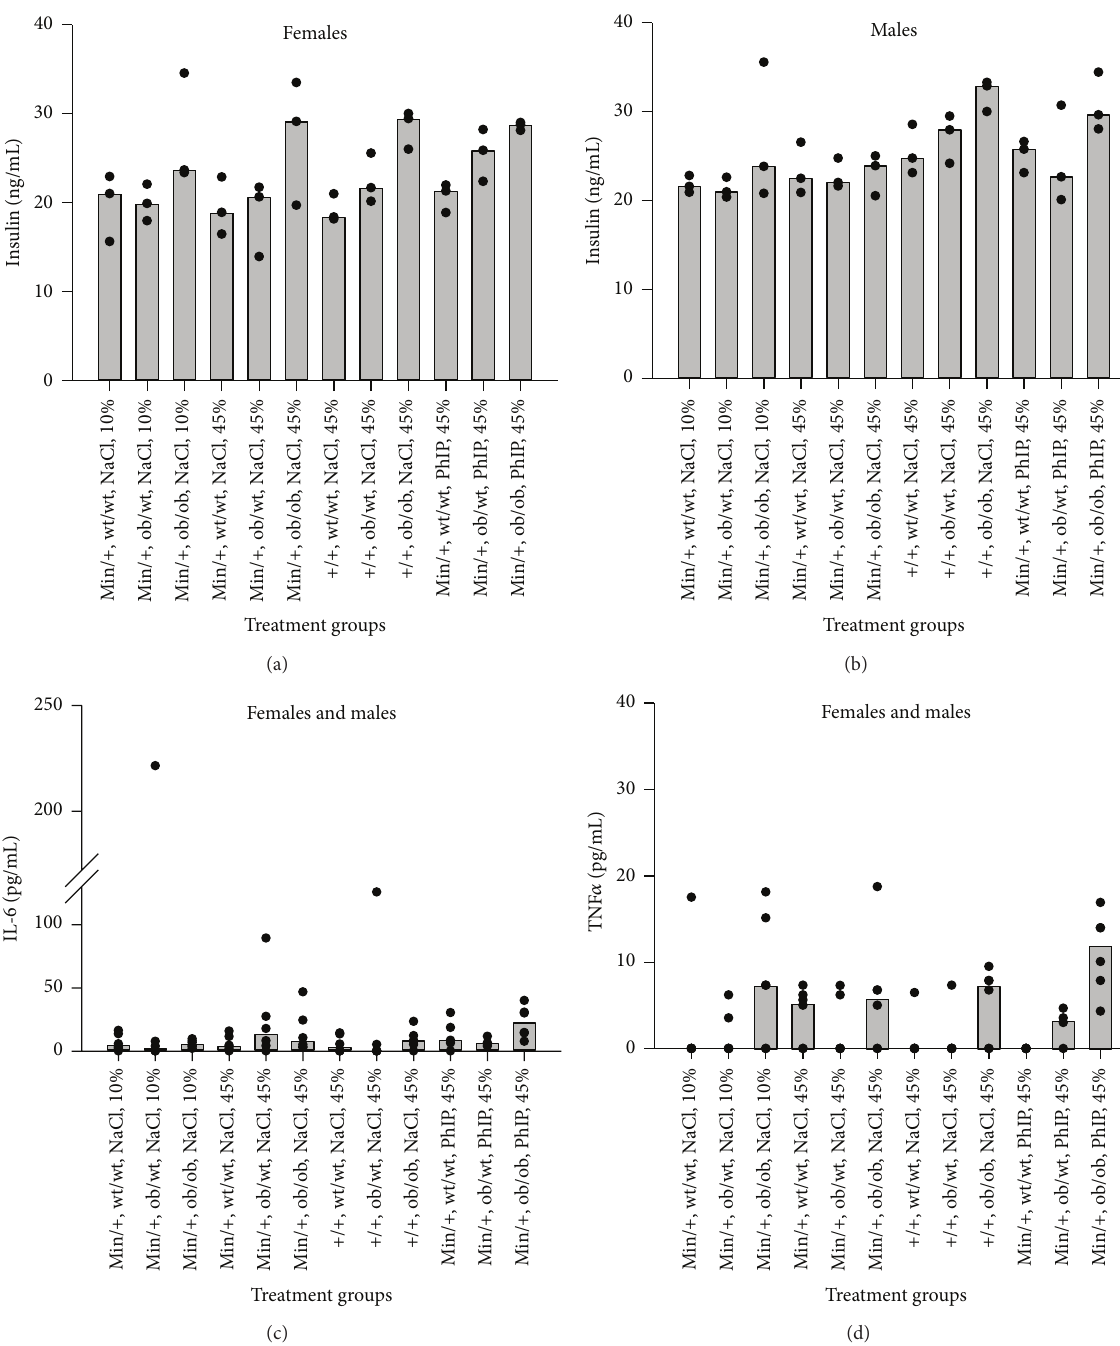
Figure 6: Levels of insulin and the proinflammatory cytokines IL-6 and TNF 𝛼 in plasma. Insulin levels (ng/mL) were measured with ELISA in plasma obtained from the mice at termination, for (a) females and (b) males (median and individual values are shown as columns and dots, resp.). IL-6 (c) and TNF 𝛼 (d) levels (both in pg/mL) were measured with bead-based immunoassays and analysed by flow cytometer in plasma obtained from the mice at termination. The data shown are from females and males combined (median and individual values are shown as columns and dots, resp.). 𝑛 = 6 mice (3 of each